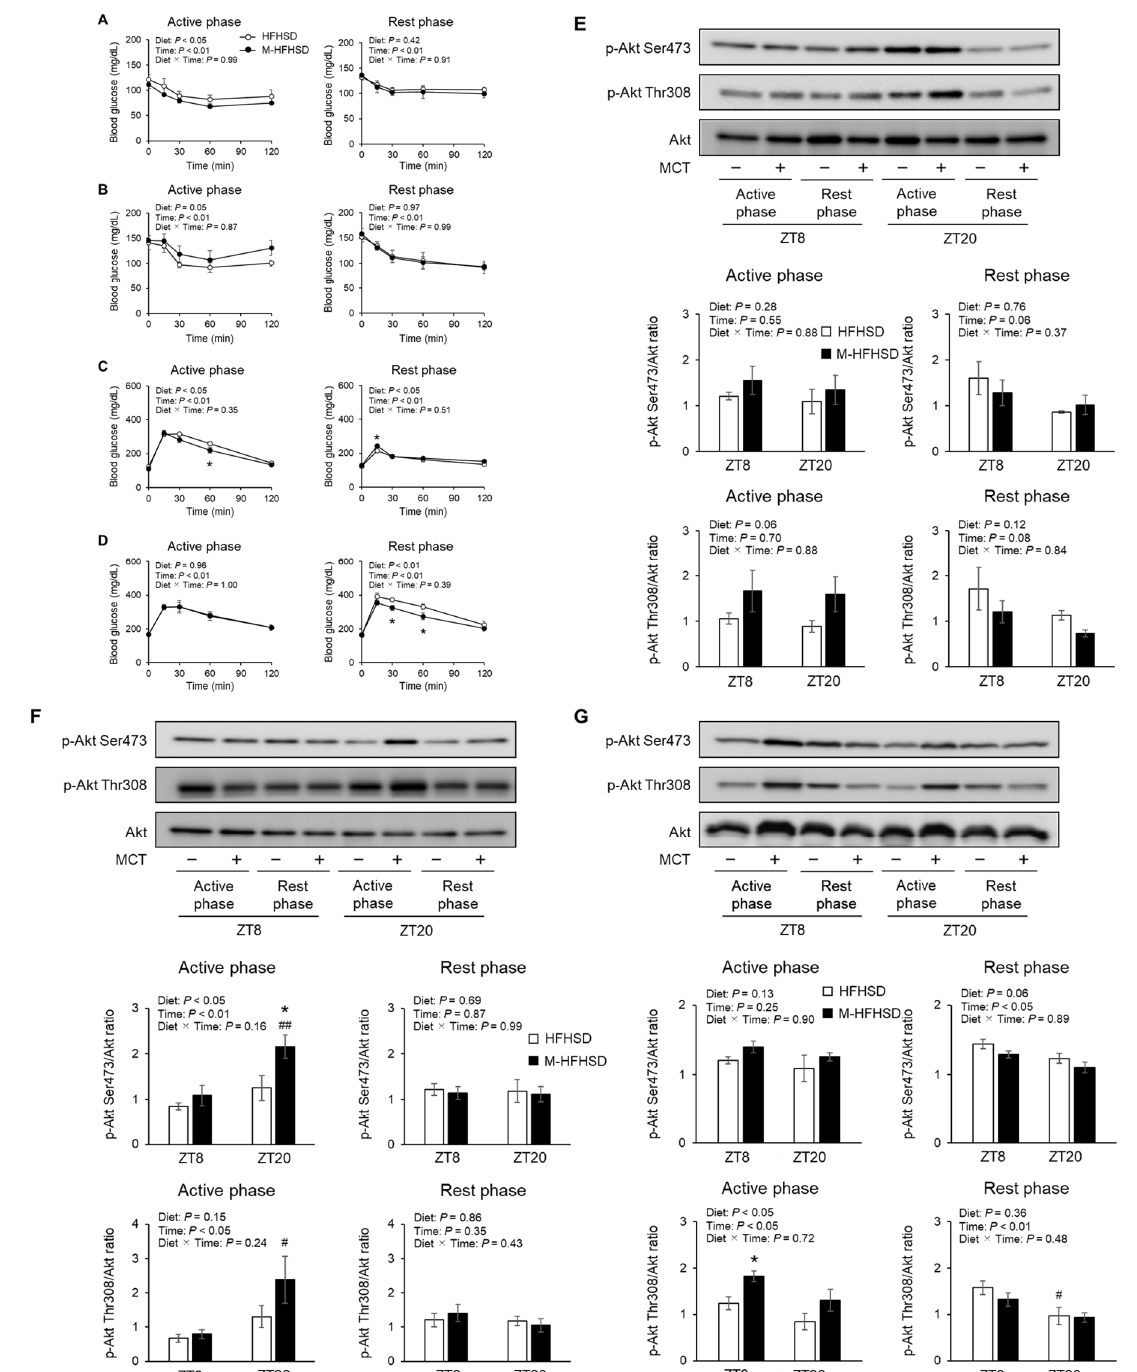
Figure 4. Insulin and glucose tolerance tests and insulin signaling in peripheral tissues. Insulin tolerance tests at feeding period ( A ) or fasting period ( B ) in mice fed HFHSD or M-HFHSD for 8 weeks. Glucose tolerance test at feeding period ( C ) or fasting period ( D ) in mice fed HFHSD or M-HFSHD for 8 weeks. Protein expression levels of phosphorylated Akt on Ser473 or Thr307 in the liver ( E ), gastrocnemius muscle ( F ), and epididymal white adipose tissue ( G ) extracts from mice. Data are mean ± SEM ( n = 4). * p < 0.05 vs. HFHSD at same time. # p < 0.05 and ## p < 0.01 vs. same diet at ZT8. HFHSD, high-fat high-sucrose diet; MCT, medium-chain triglyceride; M-HFHSD, high-fat high-sucrose diet containing medium-chain triglyceride; ZT, zeitgeber time.